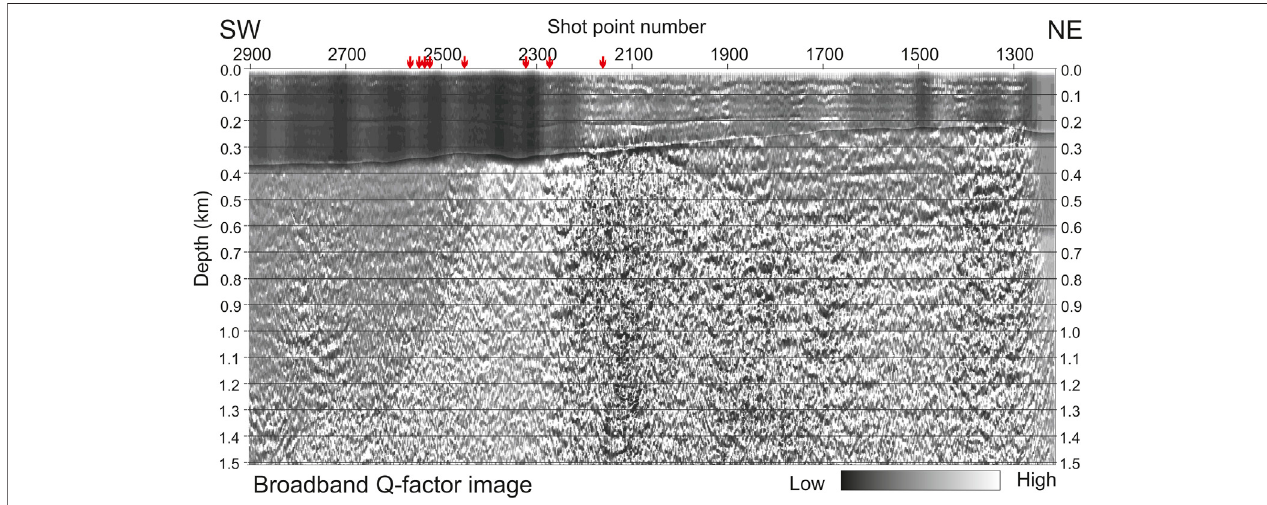
FIGURE 16 | Q factor estimation obtained by P velocity in Figure 7 and the broadband anelastic absorption coef fi cient in Figure 6 . The small red arrows on top indicate the proximity of known plume areas.